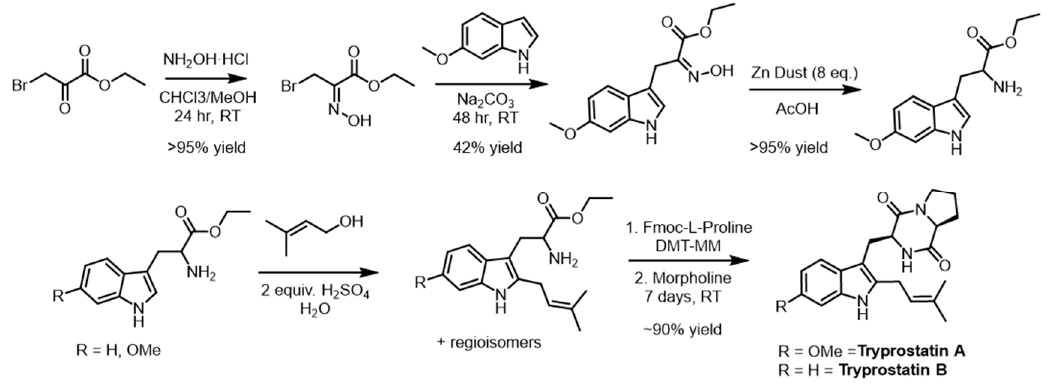
Figure 6. Synthetic schemes for the synthesis of 6-methoxytryptophan, TPS-A, and TPS-B using a previously reported biomimetic chemical prenylation.